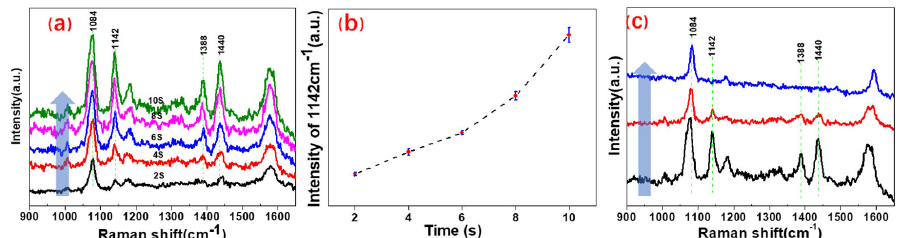
Figure 3. Raman spectra of plasma ‐ driven photocatalysis based on gold nanohole array substrate: ( a ) Raman spectrum of PATP photocatalysis generating DMAB; ( b ) the change trend of Raman peak intensity at 1142 cm − 1 with time; ( c ) Raman spectrum of DMAB reverse reaction generating PATP.